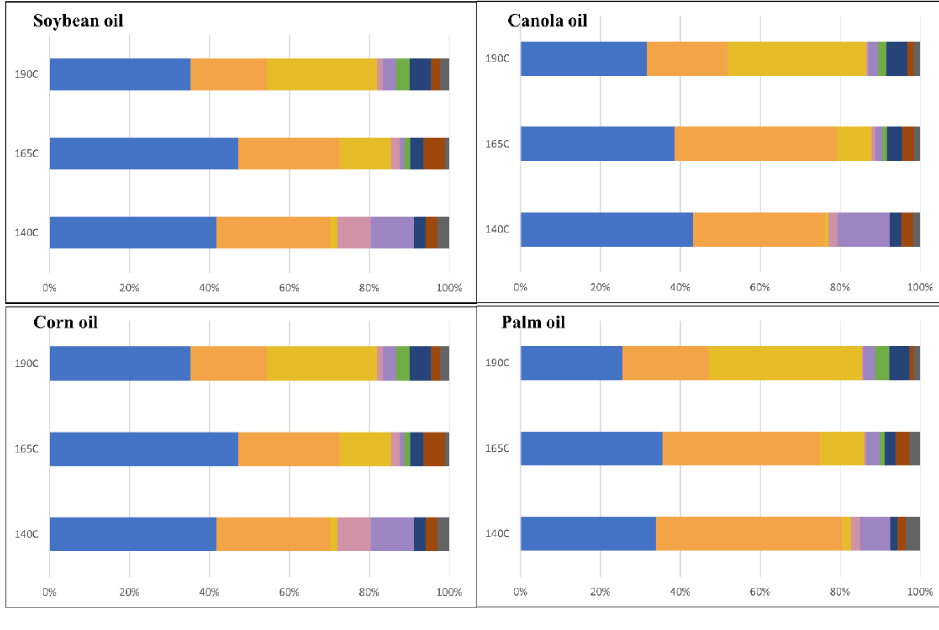
Figure 1. Quantitative composition of identified volatile compounds in WOF (Welsh onion fried) samples according to chemical functional groups. Each stacked bar is 100% wide. Each figure represents the changes in volatile compounds of WOF in different vegetable oils according to the heating temperatures.